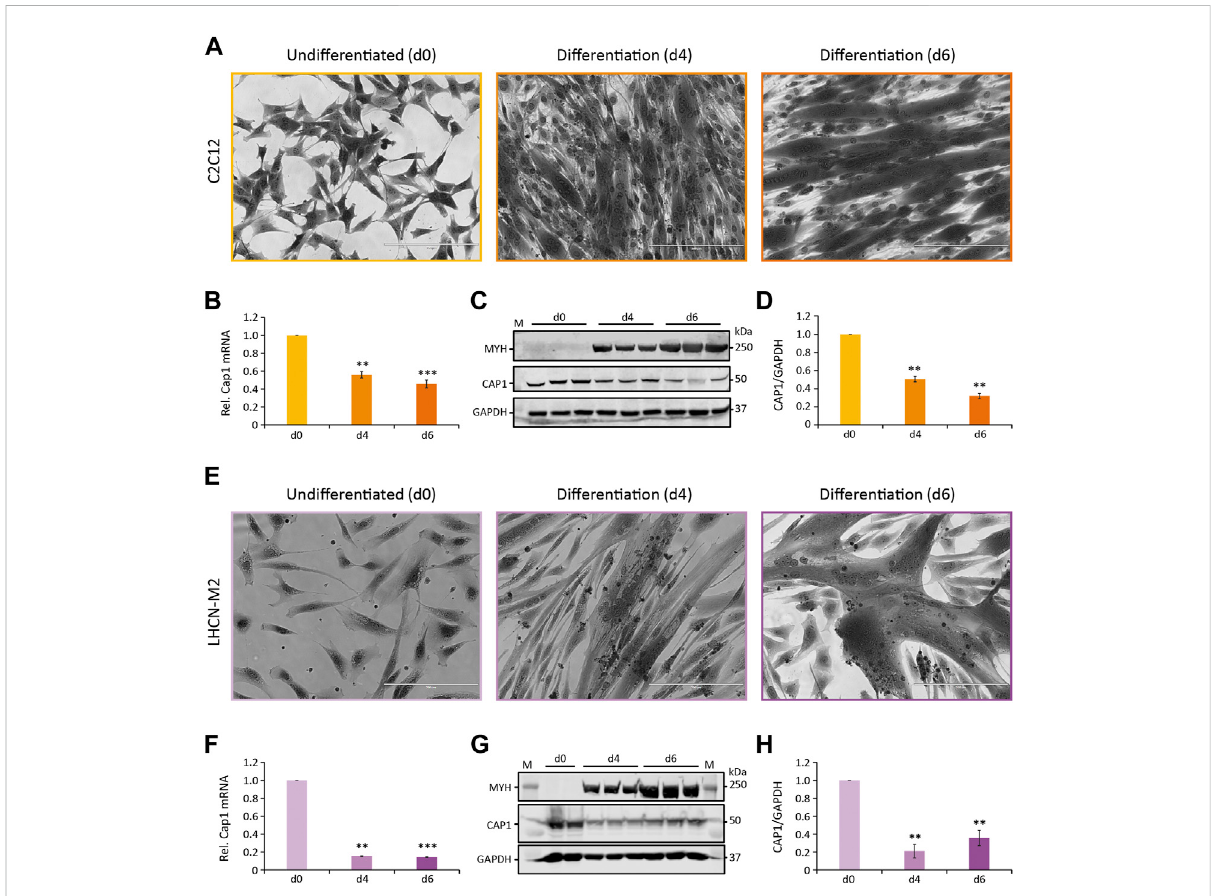
FIGURE 1 Cap1 mRNA and protein levels are downregulated during myogenic differentiation. (A,E) Bright- fi eld images (×20) of murine C2C12 (A) and human LHCN-M2 (E) cells upon differentiation for 4 and 6 days (d4 and d6), in comparison to undifferentiated control cells (d0). Cells were stained with crystal violet. (B,F) Relative Cap1 mRNA in differentiating C2C12 (B) and LHCN-M2 (F) cells, quanti fi ed by qRT-PCR and normalized to a set of housekeeping mRNAs. (C,G) Immunoblots of lysates from differentiating C2C12 (C) and LHCN-M2 (G) cells, using antibodies against myosin heavy chain polypeptides 1, 2, 4, and 6 (MYH), CAP1 and GAPDH as a control. (D,H) Quanti fi cation of CAP1 immunoblots at myogenic differentiation for 4 and 6 days, normalized to undifferentiated control cells. Error bars , SEM ( n = 3); ** p < 0.01, *** p < 0.001 (Student ’ s t -test). Scale bar, 200 μ